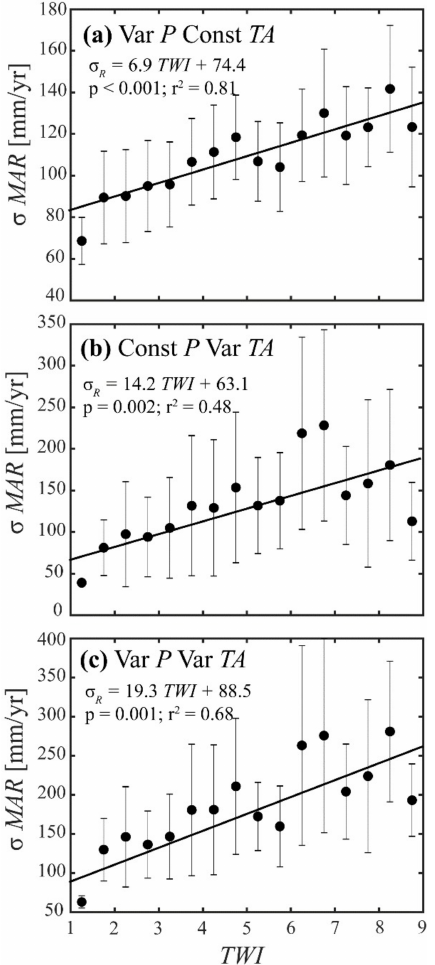
Figure 9. Scatterplots between the binned values of TWI and the standard deviation of MAR from each of the scenarios included in the WY2016 VarPConstTA experiment (a) , the ConstPVarTA ex- periment (b) , and the VarPVarTA experiment (c) in the Kaweah Terminus watershed. Circles represent the bin average, and the bars represent the bin’s standard deviation. Solid lines present statisti- cally significant ( p < 0 . 05) linear